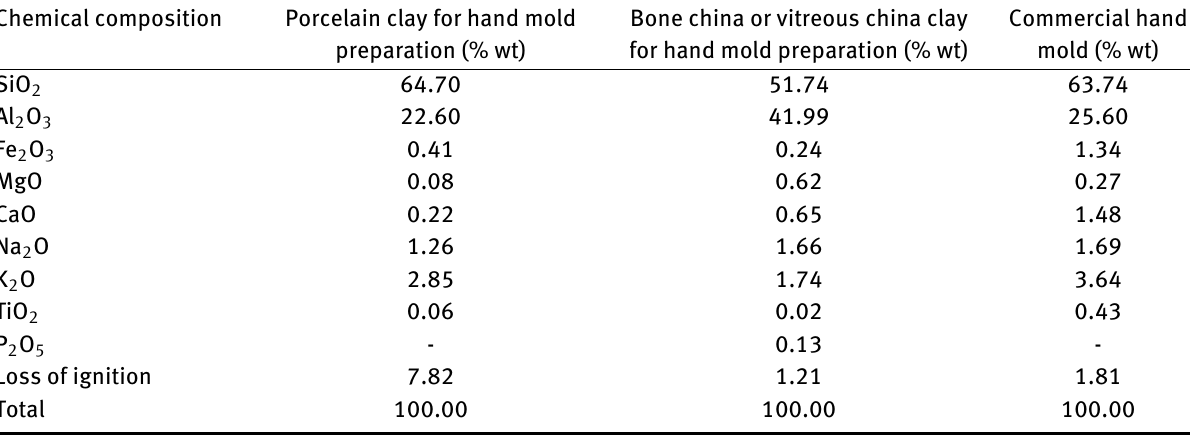
Table 3: Comparison of chemical composition between porcelain and bone china clays using XRF Chemical composition